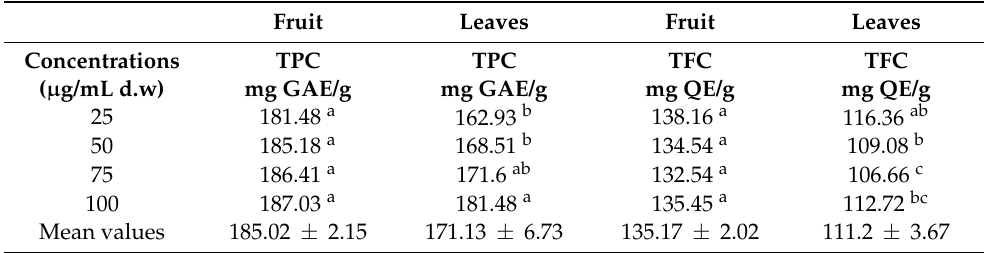
Table 1. Total phenolic contents and total flavonoids contents of the methanolic extract of A. marmelos . Fruit Leaves Fruit Leaves Concentrations TPC ( µ g/mL d.w) mg GAE/g